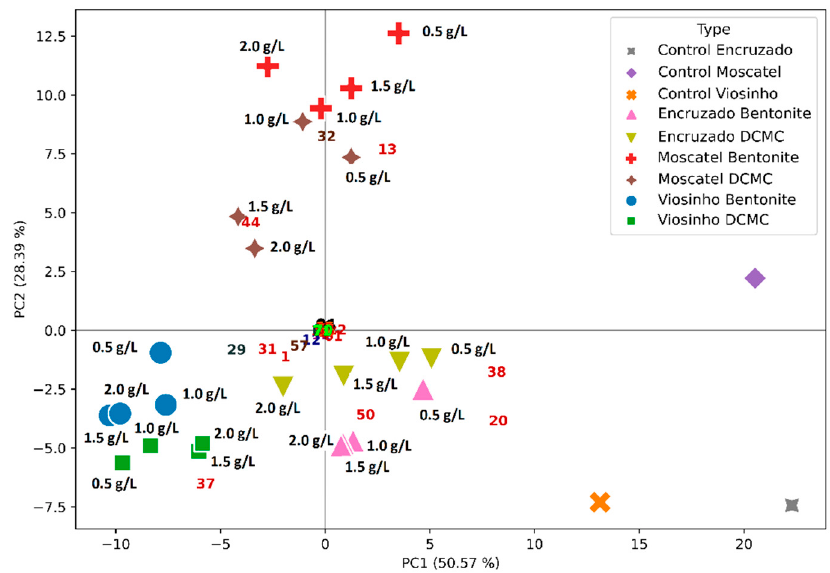
Figure 10. PCA illustrating the simultaneous projection of the wine samples (objects)—by a mark, and VOC (variables) loadings—by a number, for all wine samples under study. The different concentrations of bentonite or DCMC in g/L are indicated next to each object mark, which represents the mean value of the three replicates.